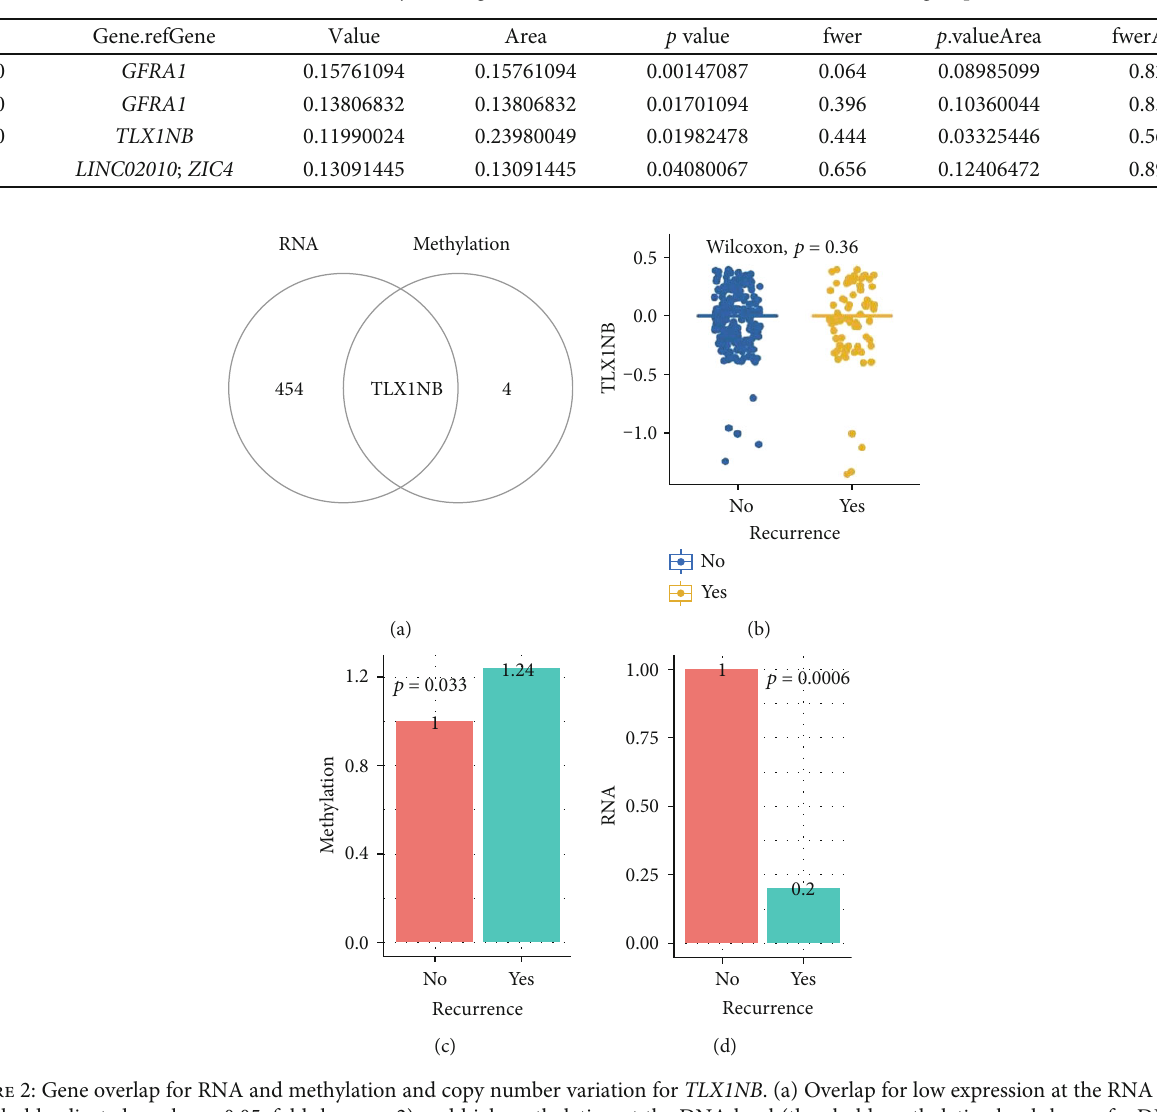
Table 2: Di ff erential methylated regions between the recurrence and nonrecurrence groups.